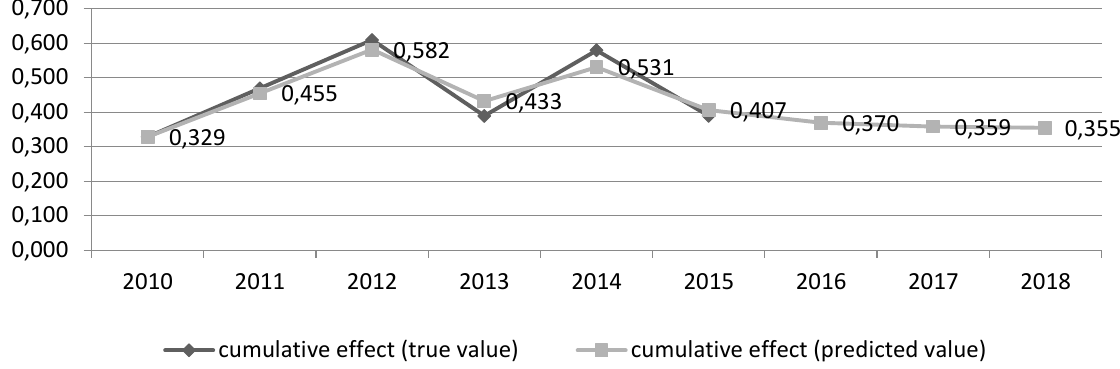
Figure 2. The dynamics of the predicted value for the cumulative effect at PJSC “Kremenchug Plant of Road Machines”